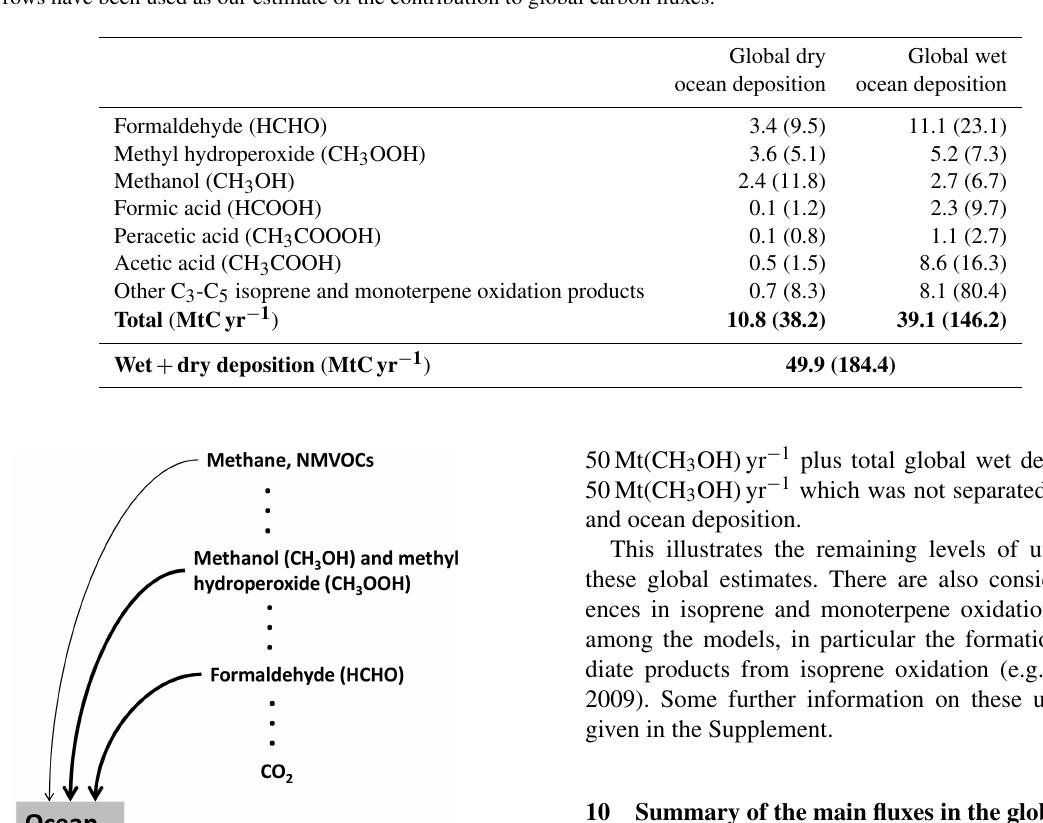
Table 3. Estimated annual carbon fluxes to the world’s oceans and globally (values in brackets) from dry and wet deposition of VOCs and their oxidation products. Data have been calculated with the NIWA-UKCA CCM model. Units are in MtCyr − 1 . The numbers in bold in the bottom rows have been used as our estimate of the contribution to global carbon fluxes.